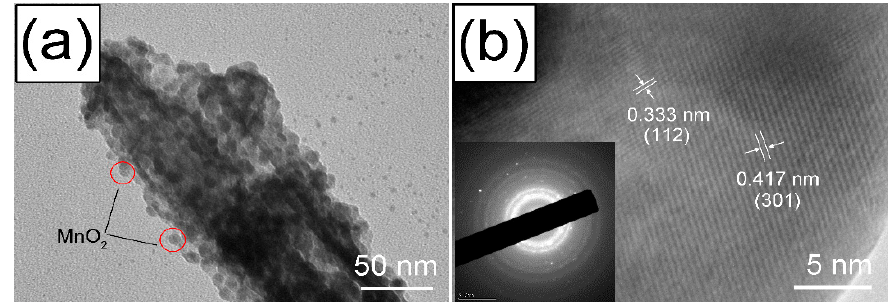
Figure 4. ( a ) Transmission electron microscopy (TEM) image of Ag 4 Bi 2 O 5 with 60% Mn, ( b ) high ‐ resolution transmission electron microscopy (HRTEM) image of Ag 4 Bi 2 O 5 with 60% Mn.